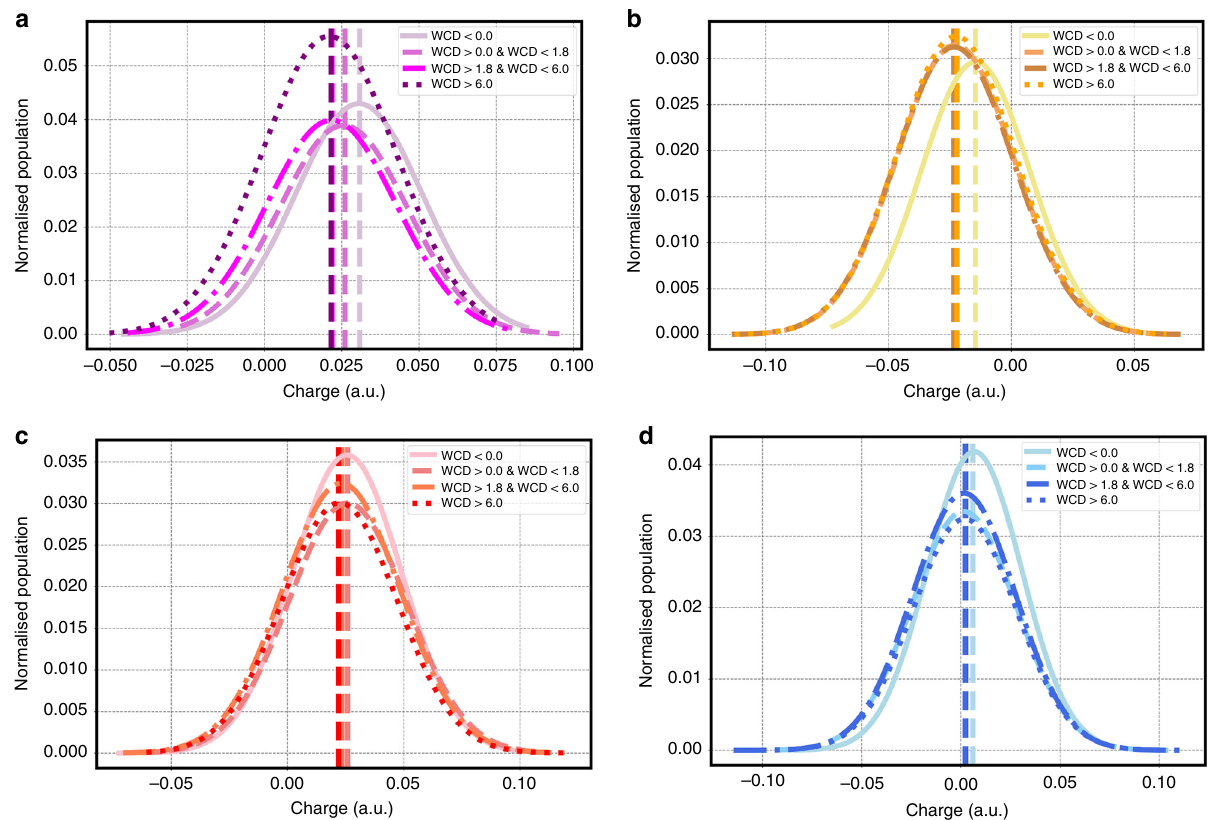
Fig. 6 Water/oil layer-by-layer charge distributions. Layer-by-layer charge distributions of the 1in-out ( a ), 1in-2out ( b ), 2in-1out ( c ), and 2in-2out ( d ) water molecules for the water – oil interface. The fi rst moment is highlighted by a vertical line for each